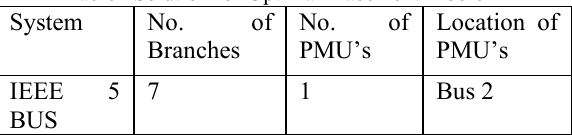
Table1 Solution for Optimal Placement Problem